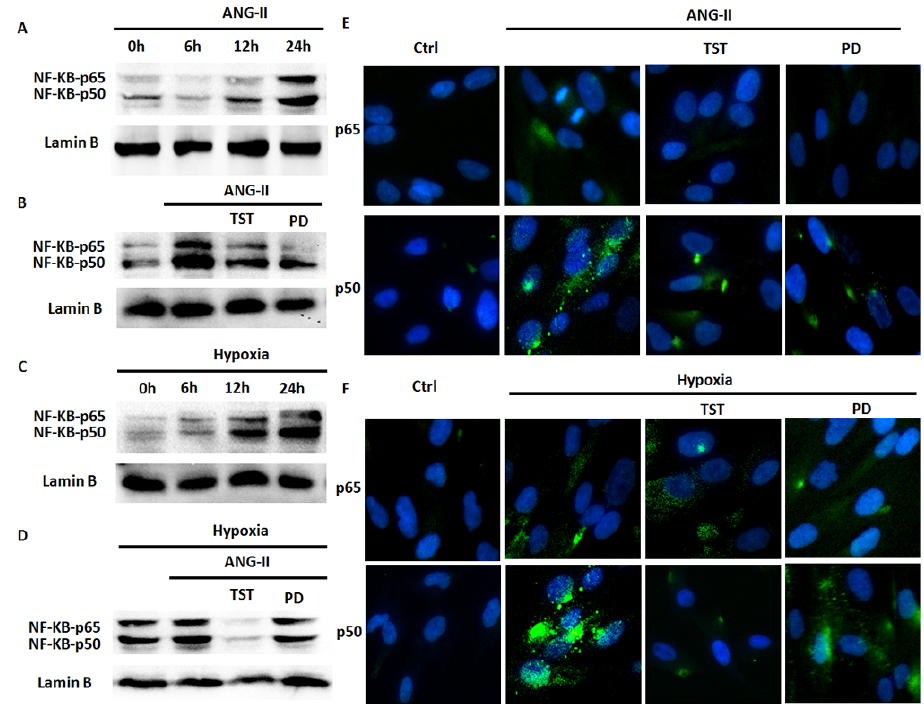
Figure 5. The role of Ang II and ATR in hypoxia-induced NF- κ B expression and nuclear translocation. ( A , C ) NF- κ B protein expression was measured using Western blot analysis. HLF-1 cells were treated with 1.0 μ M Ang II for 0, 6, 12 or 24 h; ( B , D ) NF- κ B protein expression was measured using Western blot analysis. HLF-1 cells were pre-treated with 1.0 μ M Ang II for 1 h and pre-incubated with or without 50 μ M TST or 10 μ M PD123319 (PD) for 1 h and then exposed to normoxia or hypoxia for 24 h; and ( E , F ) Immunolocalisation of p65 and p50. HLF-1 cells were pre-treated with 1.0 μ M Ang II for 1 h and pre-incubated with or without 50 μ M TST or 10 μ M PD123319 (PD) for 1 h and then exposed to normoxia or hypoxia for 24 h, after which an immunofluorescence analysis of NF- κ B nuclear translocation was performed with fluorescence